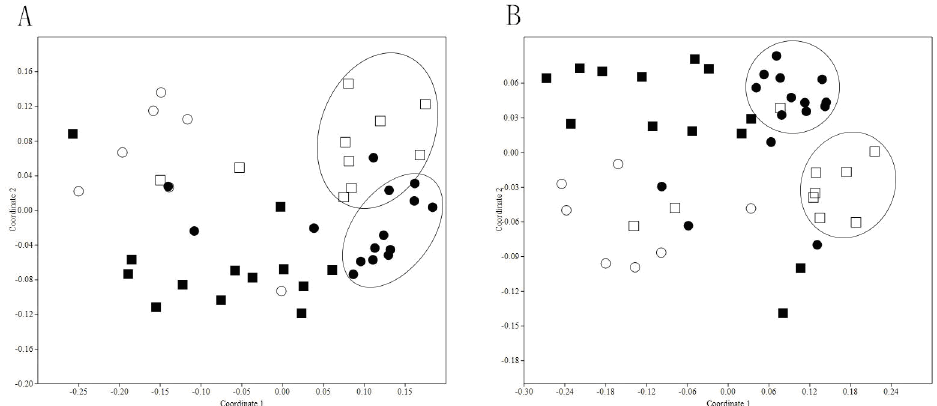
Fig 3. NMDS plots of absolute abundance of tet genes (A) and all the ARGs (B). ( (cid:1) :organic fertilizer; ● : porcine manure; □ :poultry manure; ■ :cattle manure) (Bray-Curtis similarity coefficients were calculated from absolute abundance of ARGs and plotted in a multidimensional scaling graph. The distance between points indicates the degree of difference in the diversity of ARGs between